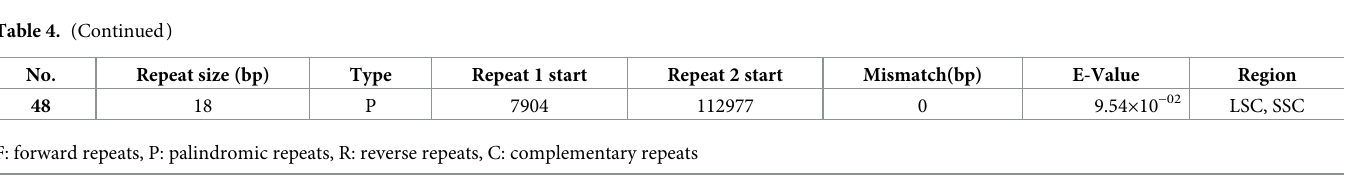
in the LSC and six regions ( ndhF , ccsA , rpl32-trnL , and three regions in ycf1 ) in the SSC of the chloroplast genomes. These regions may be undergoing more rapid nucleotide substitution at the species level, indicating the potential application of molecular markers for phylogenetic analyses and plant identification in the genus Isodon . In addition, the average nucleotide diver- sity (K value) of IR-L compared with IR-X , IR-J , I . serra (MT317099.1), and I . lophanthoides